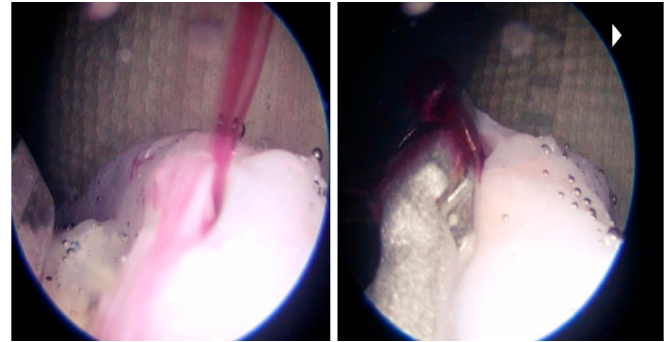
Figure 6. Intraventricular view showing basilar artery bleed.